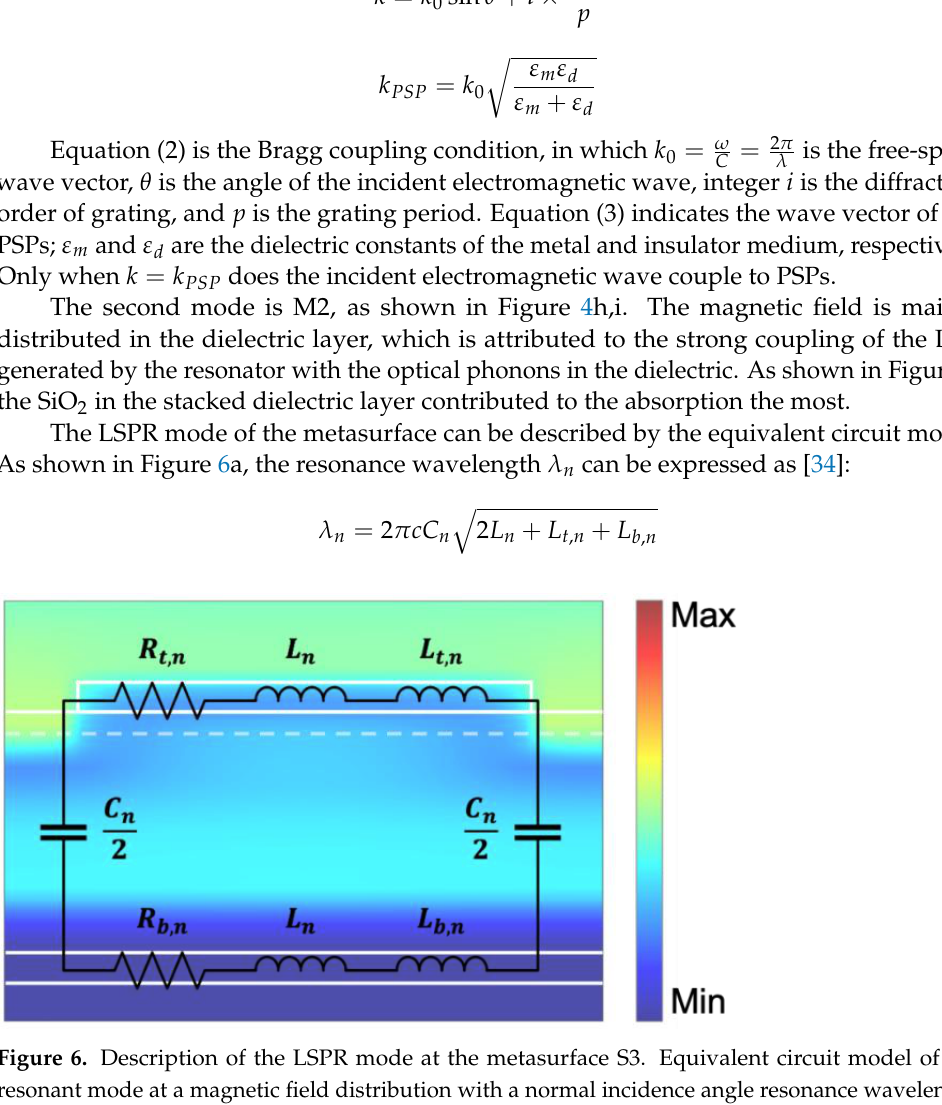
such that L n = 0.5 µ 0 dl